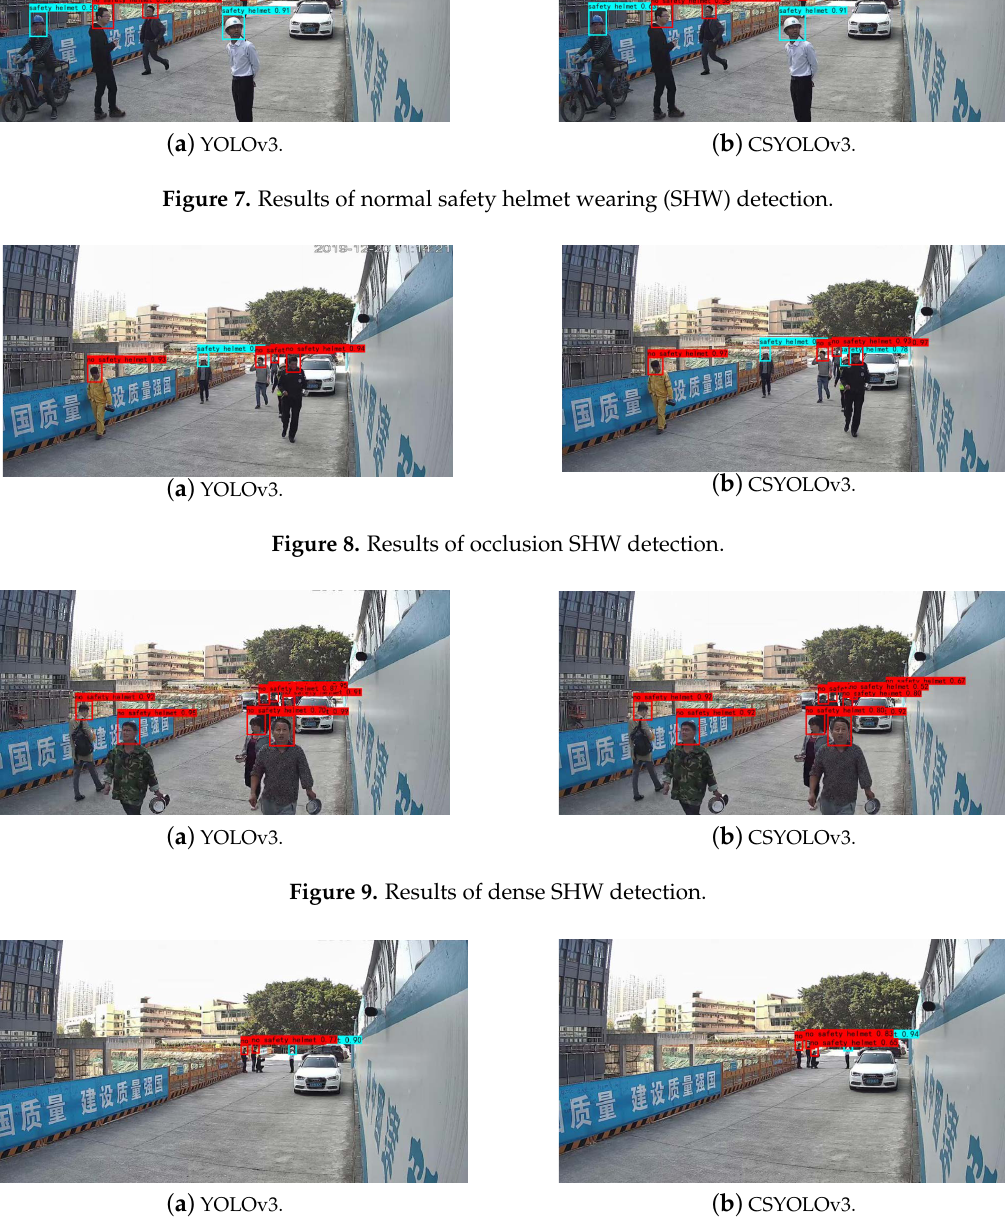
Figure 10. Results of small size SHW